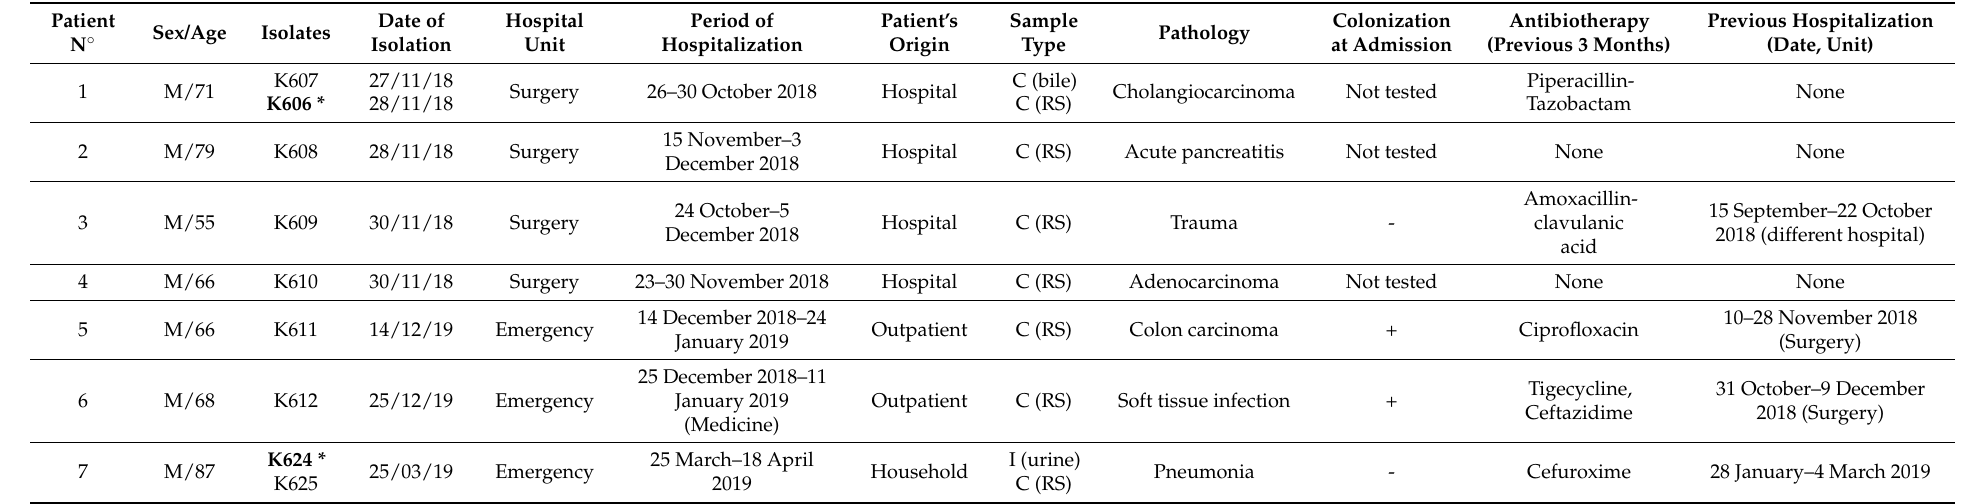
* Isolates selected for whole-genome sequencing. M = male; C = colonization; I = infection; RS = rectal